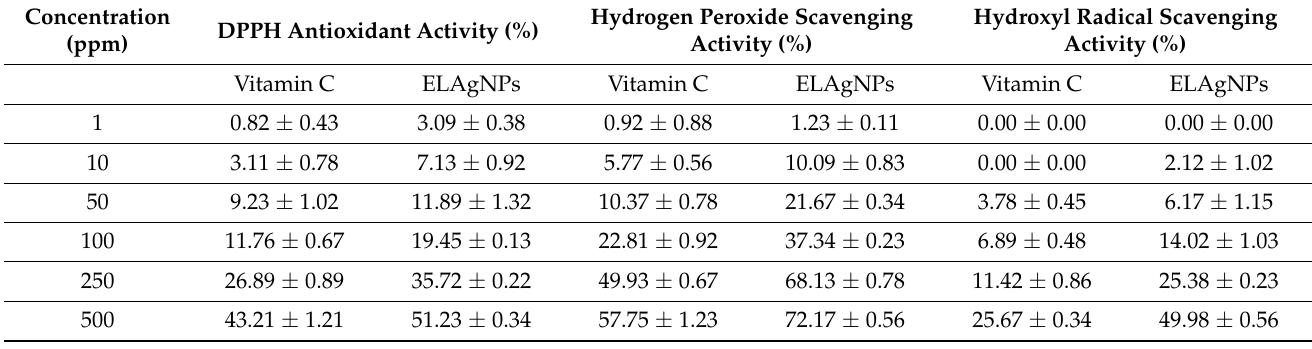
Table 1. Antioxidant activity of ELAgNPs.